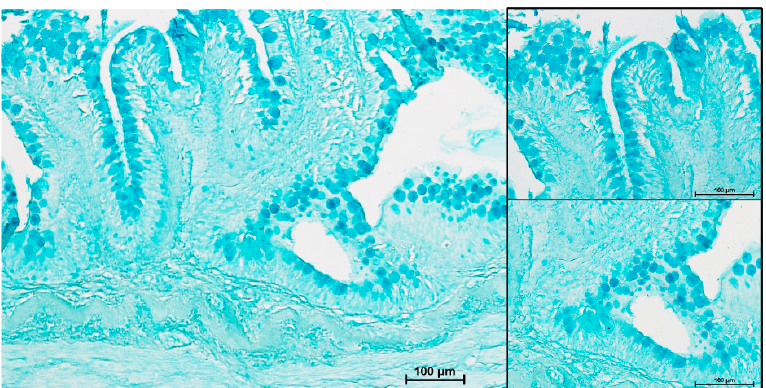
Figure 9. Representative figure of AB pH 2.5 stained section of the anterior intestine of rainbow trout.